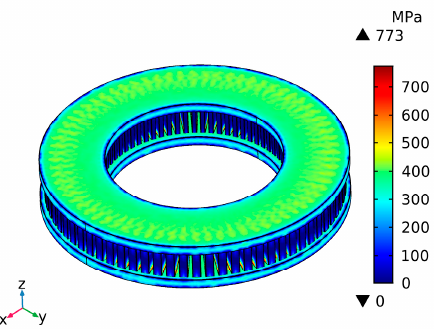
Figure 16. Ventilated disc surface stress cloud at 19 s braking.